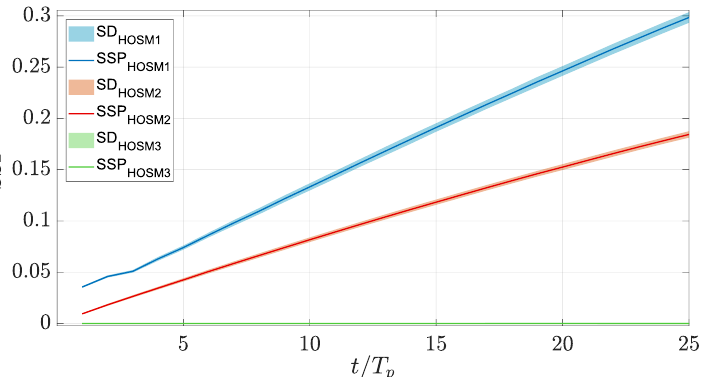
Figure 3. Numerical results: mean value and standard deviation of the SSP of 30 independent sea state realizations (initial random phase distributions)—the basis is Sea State 12 with spreading factor s = 4 (see Table